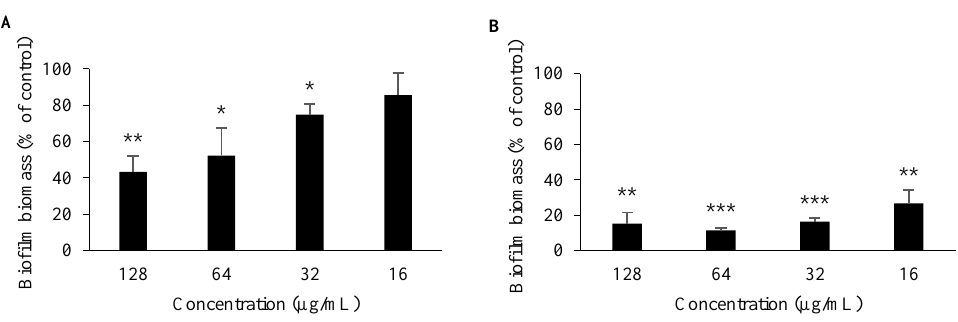
Figure 5. Percentage of C. albicans ATCC 10,231 biofilm formation after 48-h incubation with 3 ( A ), 26 ( B ). Data are shown as mean ± SD of three independent assays. One-sample t-test: * p < 0.05, ** p < 0.01, *** p < 0.001 significantly different from 100%.